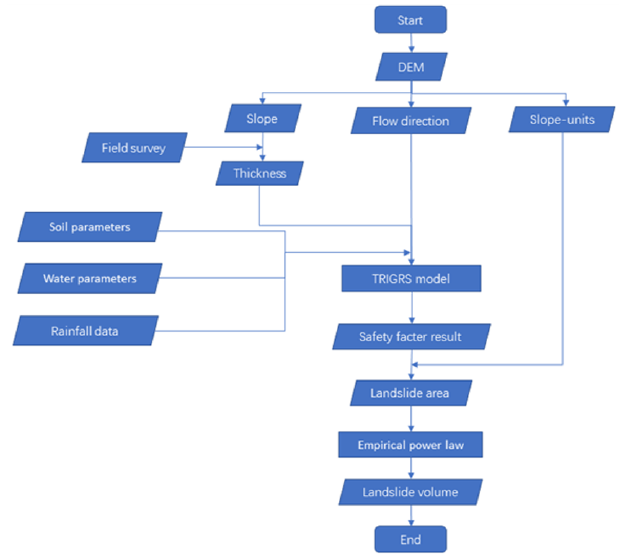
Figure 3. The workflow of this